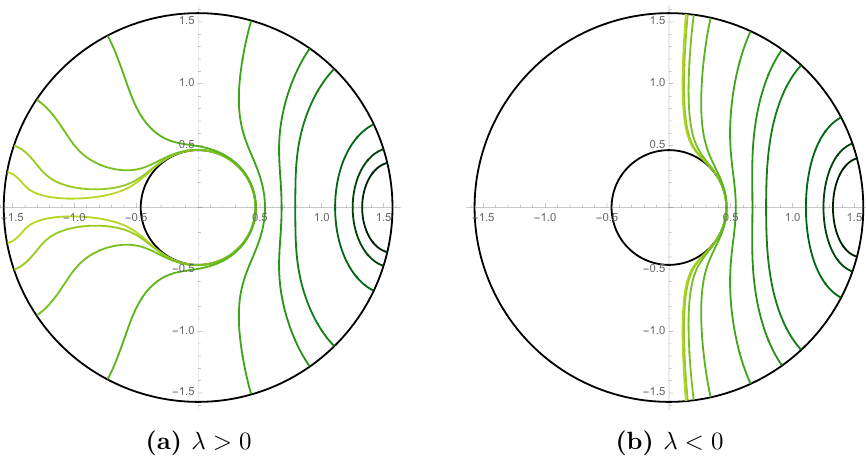
Figure 4. Entanglement minimal surfaces (cid:0) A for the functional (3.3), at (cid:12)xed horizon radius r h = 0 : 5 and (cid:12)xed Gauss-Bonnet coupling (cid:21) . We adopt polar coordinates ( (cid:26); (cid:30) ), where (cid:26) = tan (cid:0) 1 r is a compacti(cid:12)ed radial coordinate. The inner and outer circles represent the black hole horizon and the boundary, respectively. The angle (cid:30) A that de(cid:12)nes the entangling surface has range 0 (cid:20) (cid:30) A (cid:20) (cid:25) , so that the curve that appears at the bottom is just a re(cid:13)ection (cid:30) ! (cid:0) (cid:30) . (a) Fixed (cid:21) = 0 : 1 (b) Fixed (cid:21) = (cid:0) 0 : 1. We chose the same values of r 0 (minimal radius) for both left and right plots, namely, r 0 = 0 : 50015 ; 0 : 5002 ; 0 : 5005 ; 0 : 505 ; 0 : 6 ; 0 : 8 ; 1 ; 2 ; 3 ; 4 (from lighter to darker